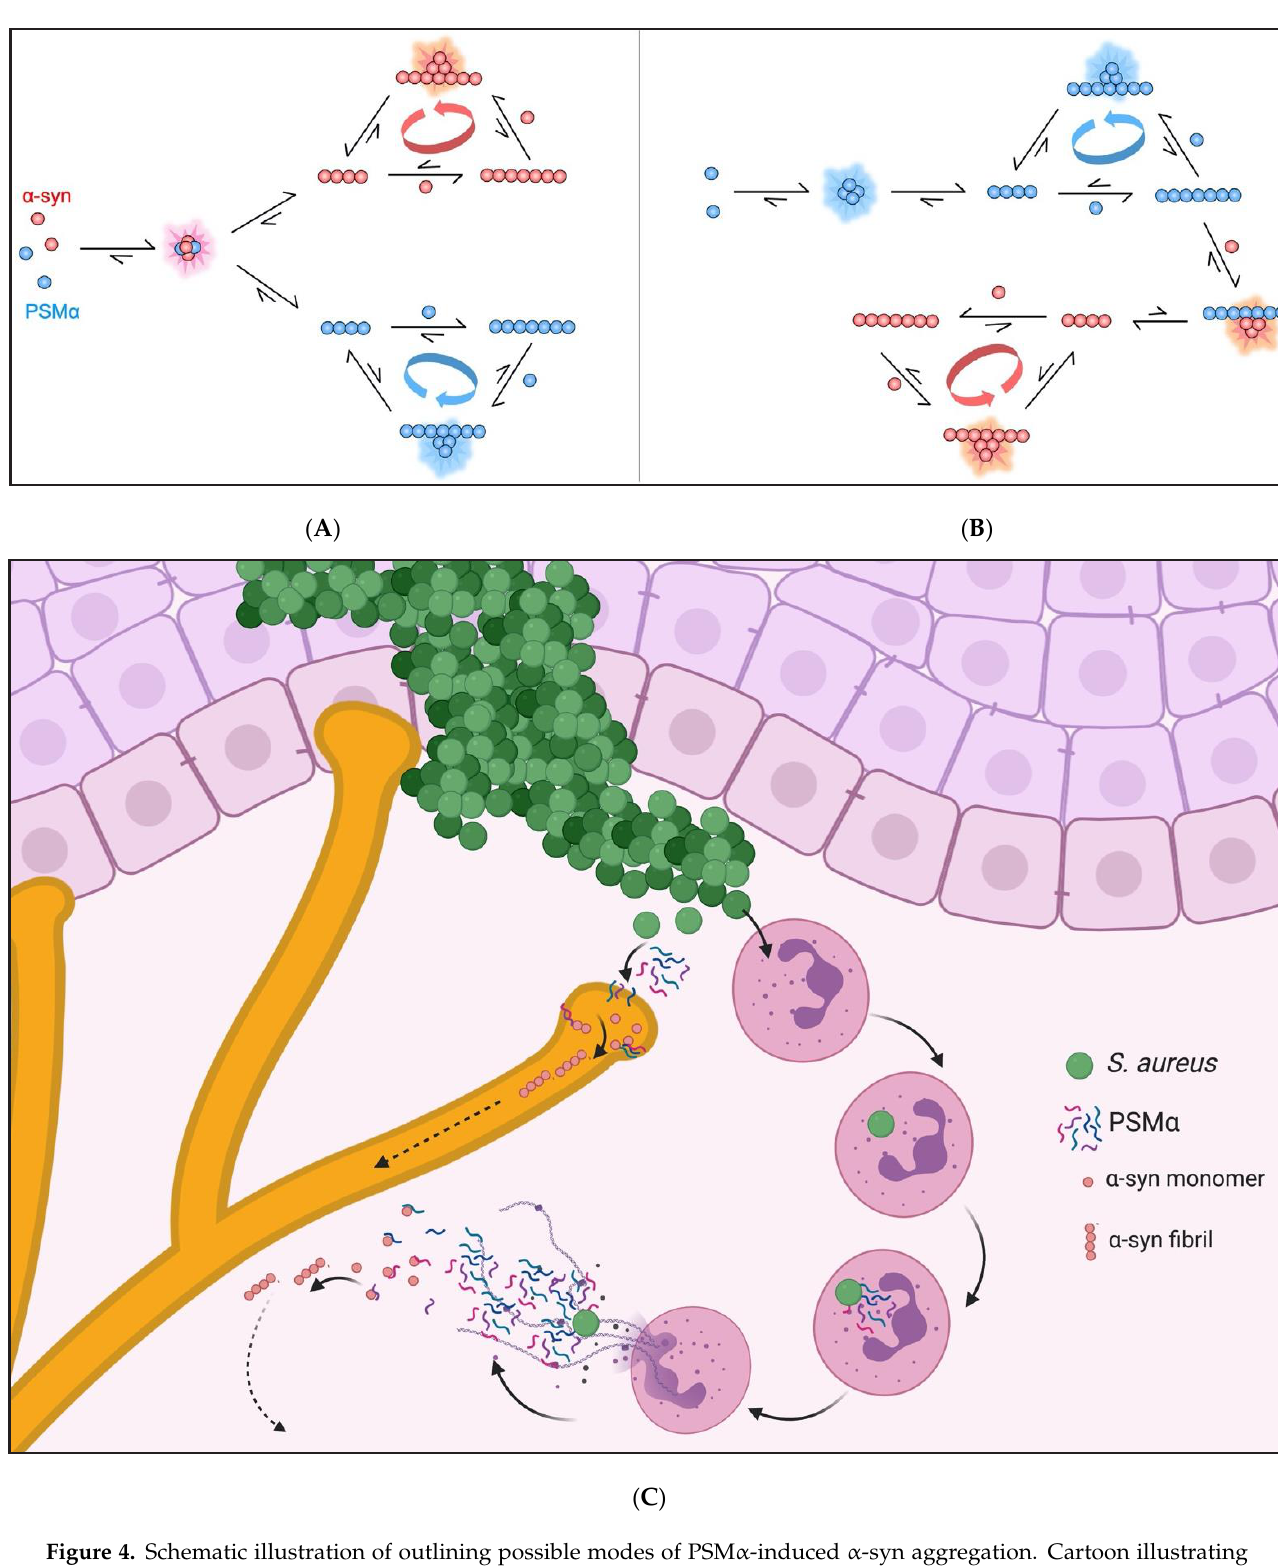
Figure 4. Schematic illustration of outlining possible modes of PSM α -induced α -syn aggregation. Cartoon illustrating two of many possible modes of cross- catalysis between PSMα (blue) and α -syn (red) involving heterogeneous primary nucle- ation. The curved arrows indicate the autocatalytic cycles that may result from homogenous secondary nucleation of each peptide on the fibrils of the same peptide. ( A ) Cross catalysis occurs via heterogeneous primary nucleation in joint oligo- mers, with no cross-catalysis at fibril level. ( B ) Separate primary nucleation, significant only for PSMα, and heterogeneous prim ary nucleation of α - syn on PSMα fibrils. ( C ) Cartoon illustrating possible routes by which S. aureus and PSMαs could lead to α -syn pathology. Invading S. aureus produces PSMα peptides that are chemoattracting neutrophils. Neutrophils